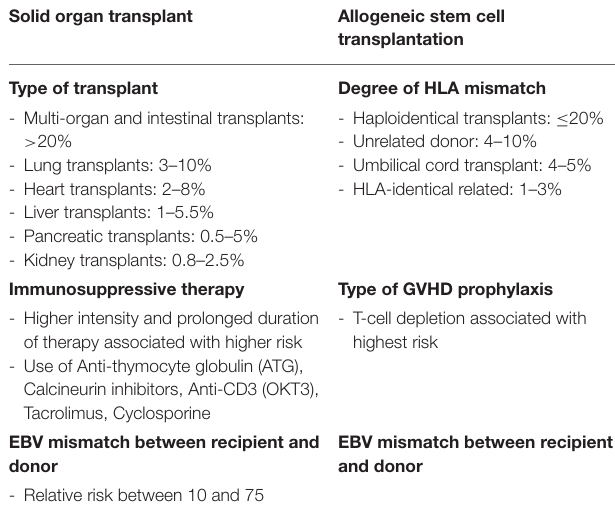
TABLE 3 | WHO classification of post-transplant lymphoproliferative disorders. PTLD category